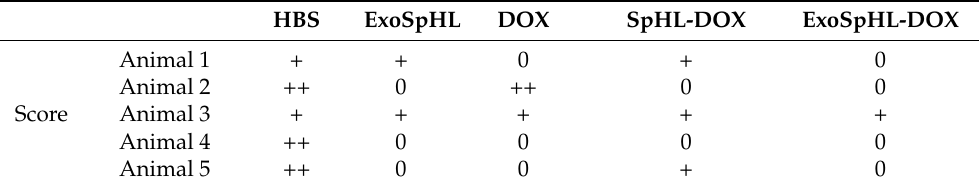
Figure 6. Representative photomicrographs of metastatic foci in the lungs ( A ) and liver ( B ) of female Balb/c mice bearing 4T1 breast tumors treated with HBS (control), ExoSpHL, or DOX at a cumulative dose of 25 mg/kg, SpHL-DOX at a cumulative dose of 25 mg/kg, or ExoSpHL-DOX at a cumulative dose of 25 mg/kg. Arrows indicate tumor metastasis. HE, scale bar = 50 µm. Table 4. Number of metastatic foci in the lungs of female Balb/c mice bearing 4T1 breast tumors treated with HBS, ExoSpHL, free DOX, SpHL-DOX, or ExoSpHL-DOX. Animals received each treatment intravenously five times at a dose of 5 mg/kg every 2 days.